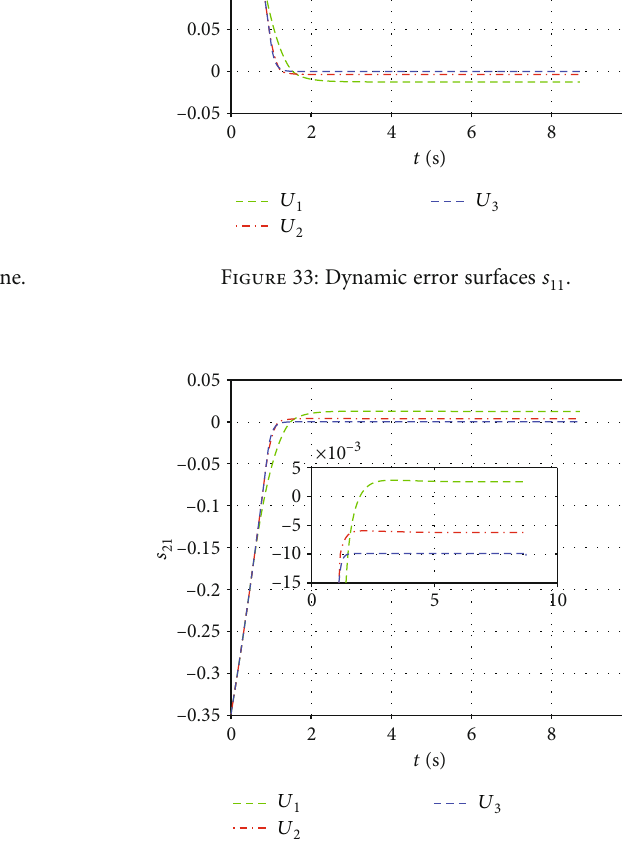
Figure 34: Dynamic error surfaces s